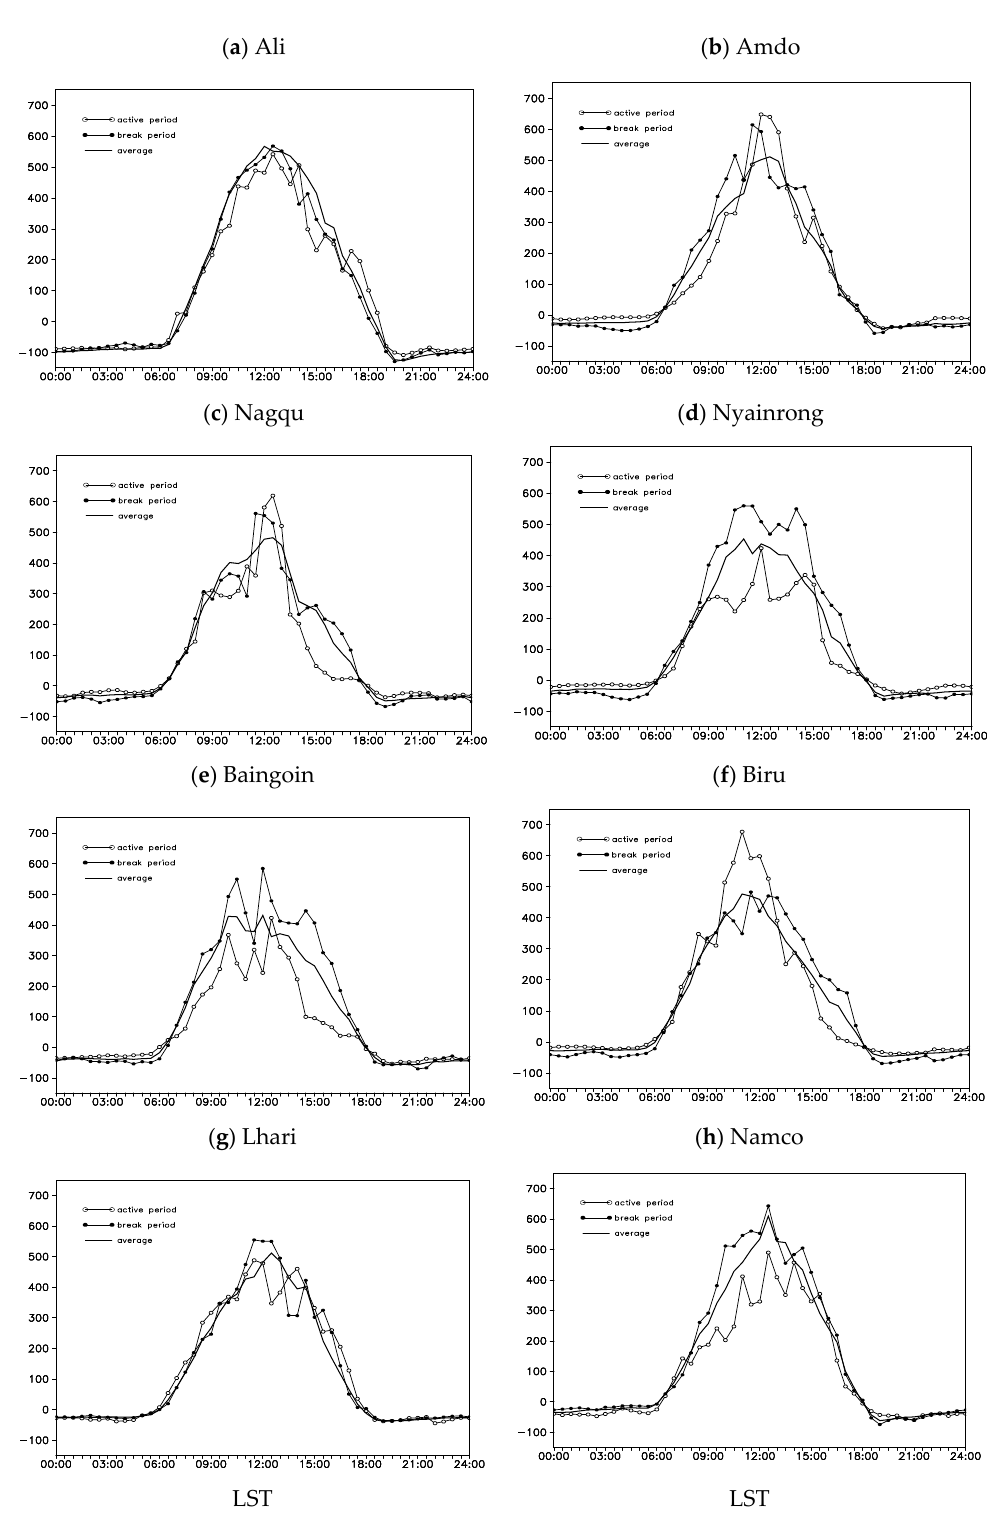
Figure 6. Same as for Figure 5, but for the net radiation flux (NR) (units: Wm − 2 ).